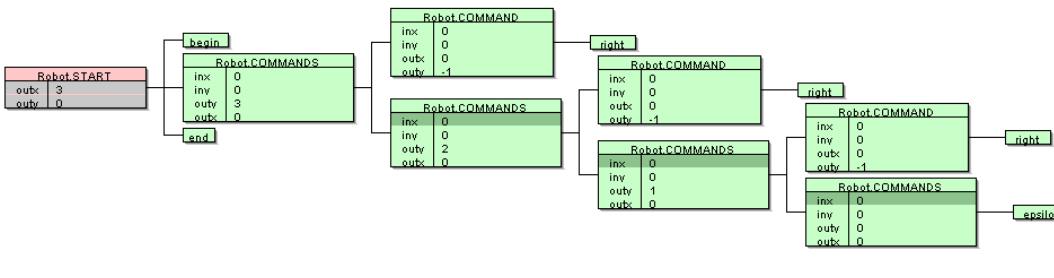
Figure 7. Robot language example 1.